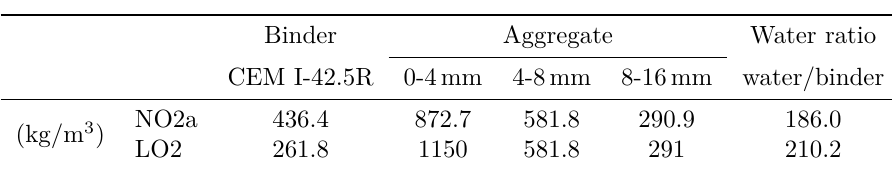
Table 1. Definition of concrete composition.